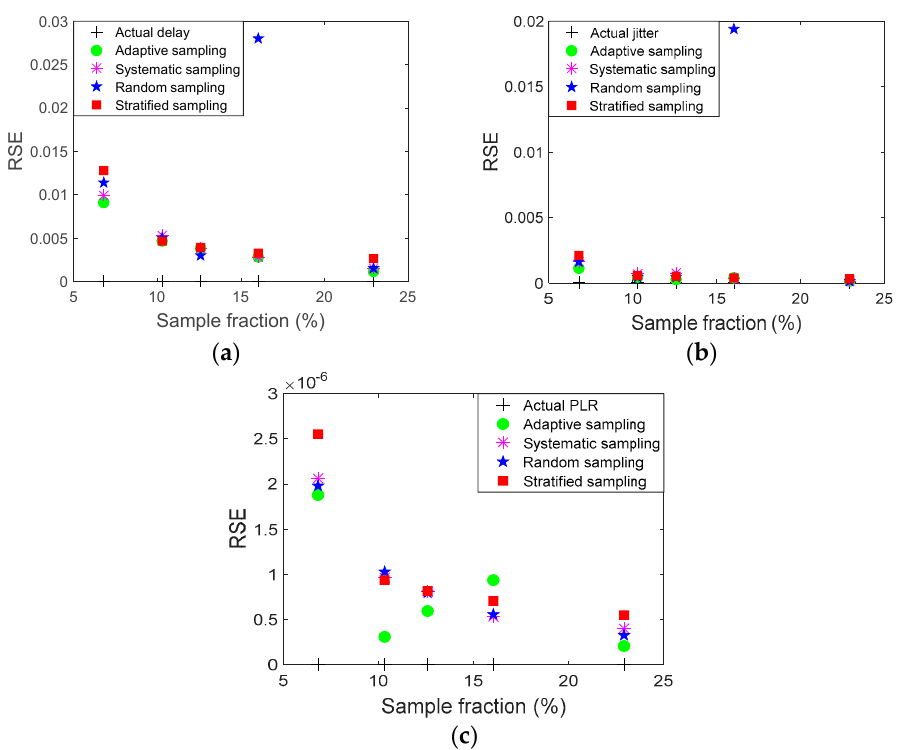
Figure 11. Comparisons of RSE of ( a ) delay, ( b ) jitter, and ( c ) PLR between the developed technique and nonadaptive methods.